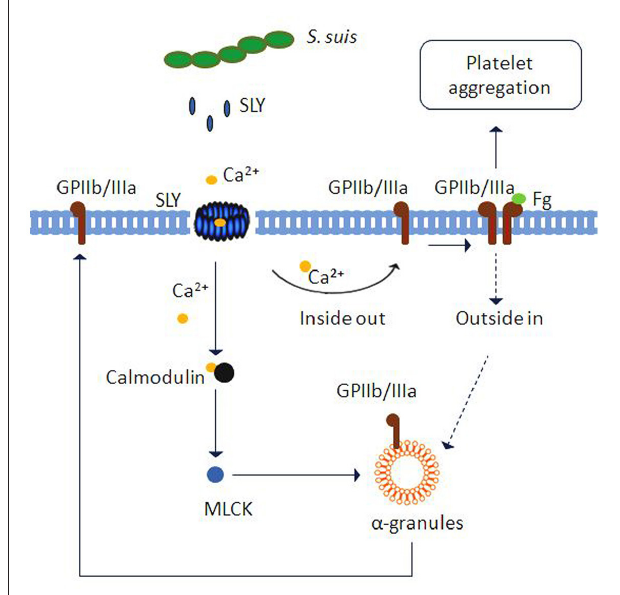
FIGURE 8 | Schematic representation of platelet activation and aggregation induced by S. suis . Ca 2 + influx across transmembrane pores created by SLY, the CDC of S. suis , can trigger inside-out signaling leading to integrin GPIIb/IIIa activation and α -granule (GPIIb/IIIa) or dense granule (ATP) secretion. Subsequently, GPIIb/IIIa activation leads to platelet aggregation. Additionally, Ca 2 + -MLCK signaling is involved in α -granule release induced by SLY.